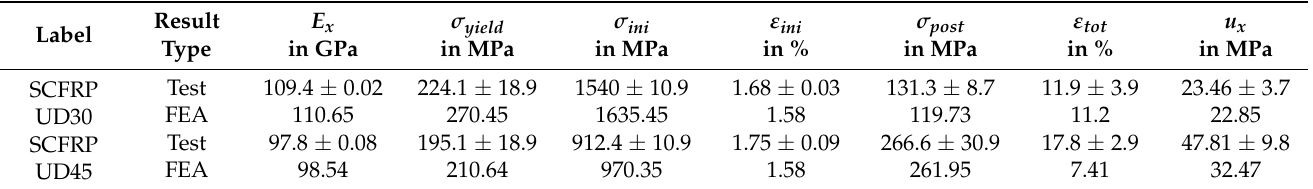
Figure 8. Experimentally determined and numerically predicted stress–strain behavior for the SCFRP_UD_30 specimens in ( a ) and the SCFRP_UD_45 specimens ( b ) in comparison of the elongation measured in the initial damage area with the elongation of the entire specimen during a tensile test of a SCFRP_UD_30 specimen in ( c ), and comparison of the damage evolution in the experiment and the initially damaged element in the calculation model for a SCFRP_UD_45 specimen in ( d ). Table 4. Experimentally determined and numerically predicted mechanical properties for SCFRP laminate with a steel fiber volume fraction of approx. 30% and with approx. 45% (for property identification see Figure